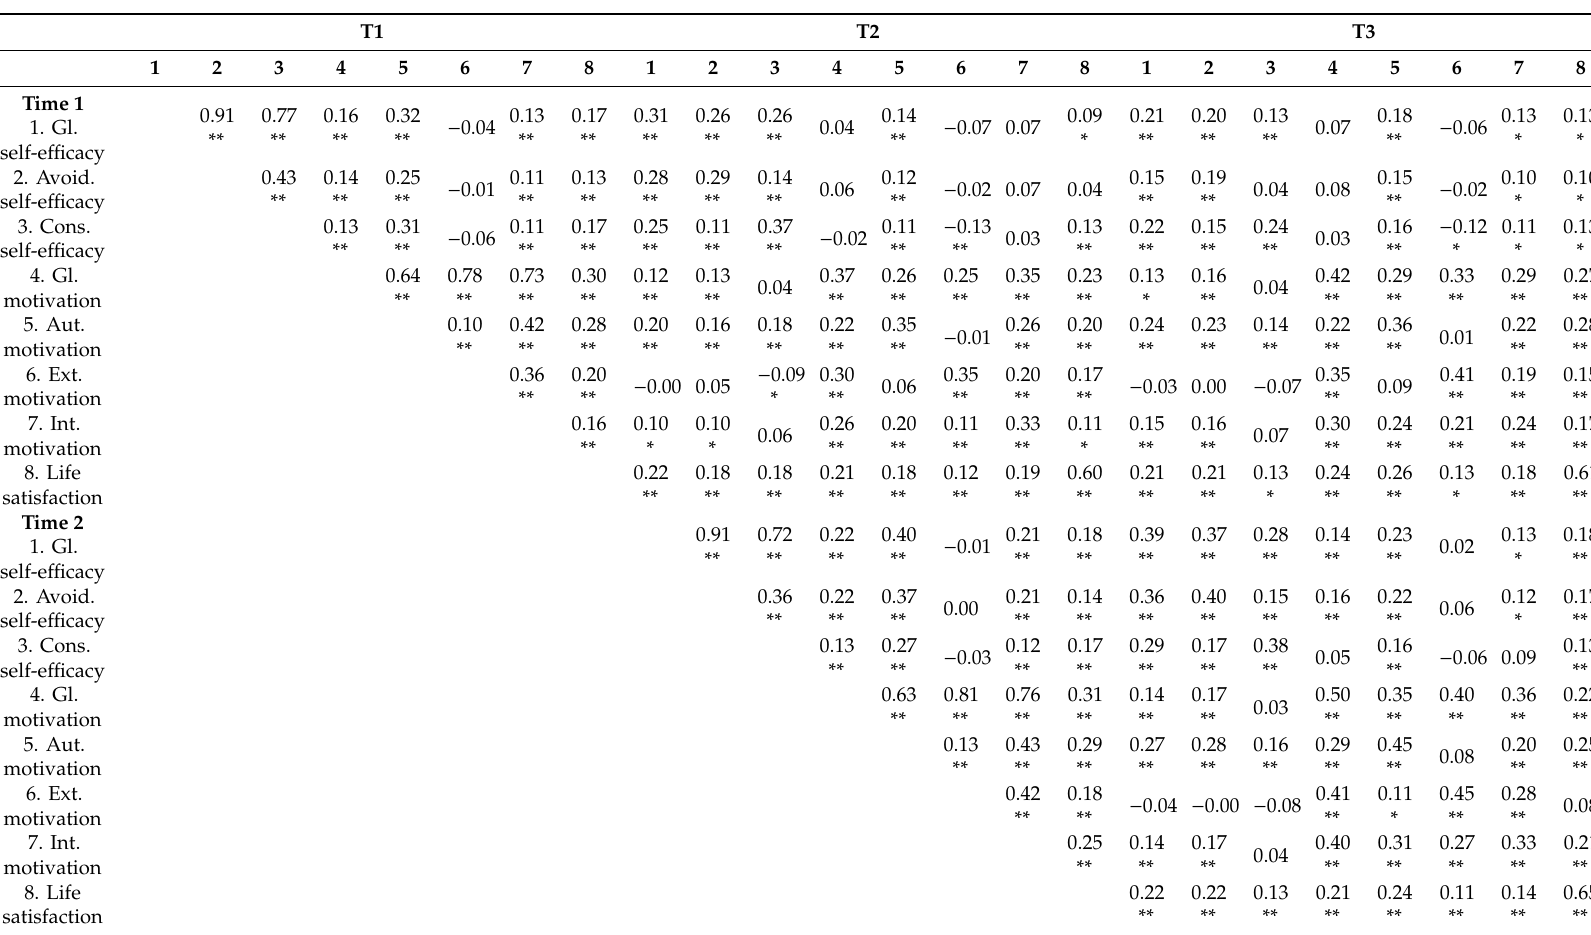
Table 2. Correlations, means (M), standard deviations (SD), and Cronbach’s alpha values of global scales and subscales at the three measurement